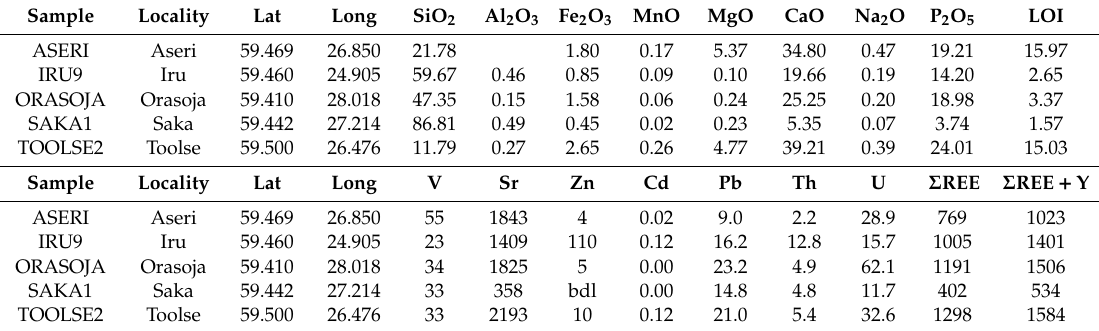
Table 3. Major (wt%) and trace (ppm) elements of some phosphorite samples. LOI—Loss on ignition. Bdl—below detection limit. Data sourced from the FRAME project [43]. Locations are shown in Figure 1.